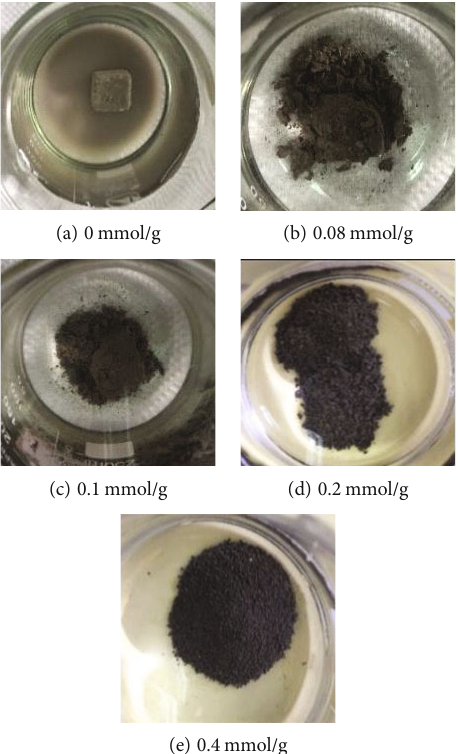
Figure 9: crumb test before and after modi fi cation with di ff erent dosages of hydroxyl aluminum. Table 3: Dispersion identi fi cation results of the soil before and after hydroxy aluminum modi fi cation. Al/soil ratio/(mmol · g - 1